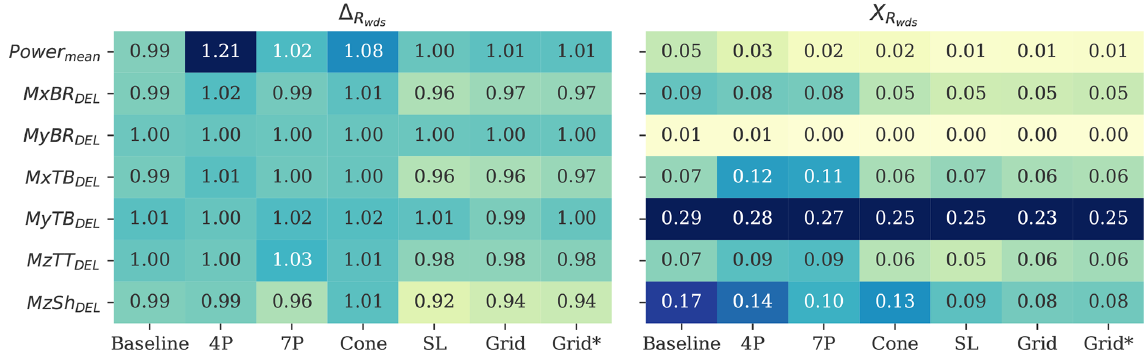
Figure 12. Uncertainty indicators of the load validation analysis based on the wake deficit superposition simulations (WDSs). Results are tabulated according to the load components and lidar scanning patterns. The color map reflects the amplitude of the error; thus dark blue identifies an overprediction while light green indicates an underprediction. A perfect statistical prediction leads to (cid:49) R = 1 and X R =